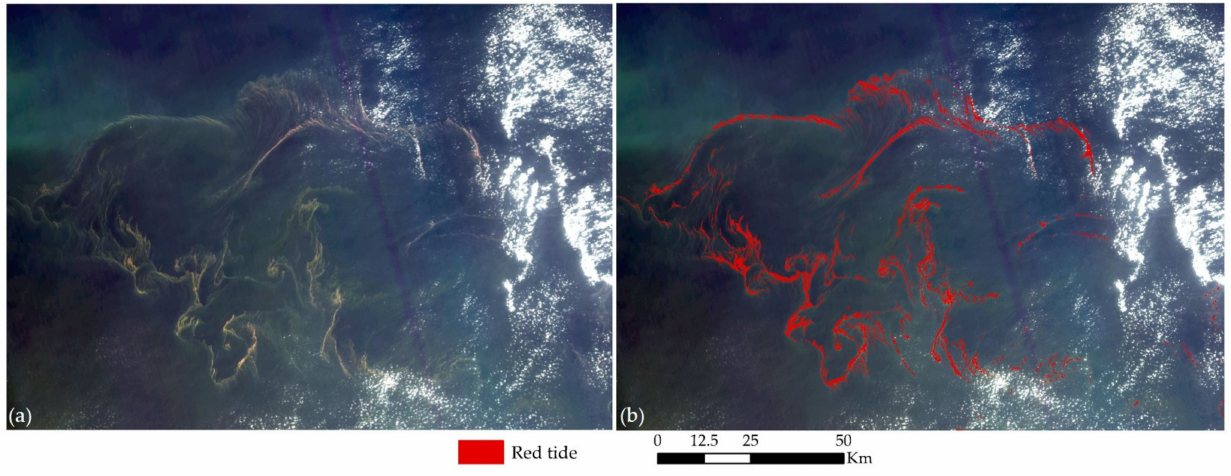
Figure 12. Red tide detection result for Rayleigh correction product. ( a ) HY − 1D Rayleigh correction product; ( b ) RDU − Net. The red regions represent red